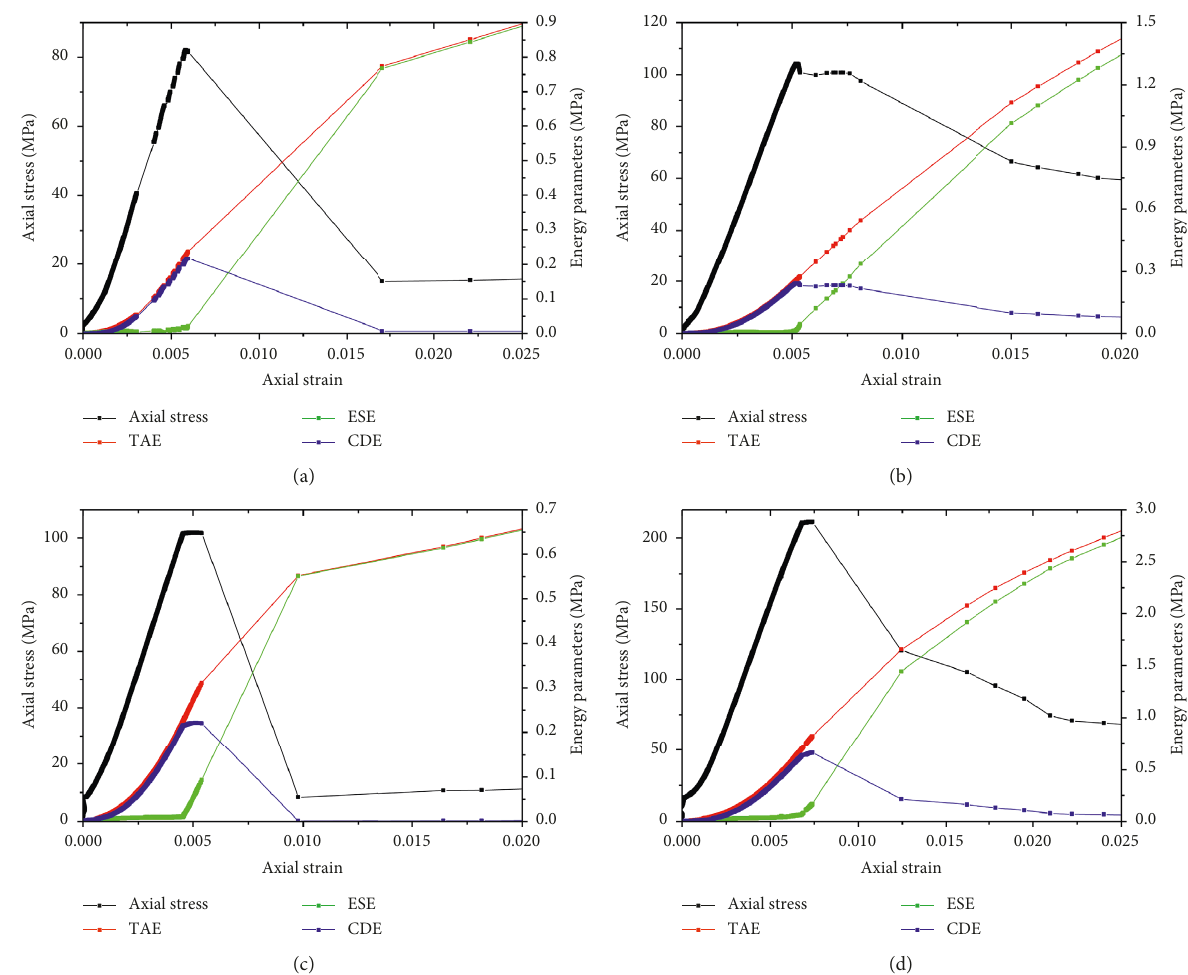
Figure 9: The energy evolution laws of b2 rocks under unloading conditions: (a) 2MPa; (b) 4MPa; (c) 8 MPa; (d)